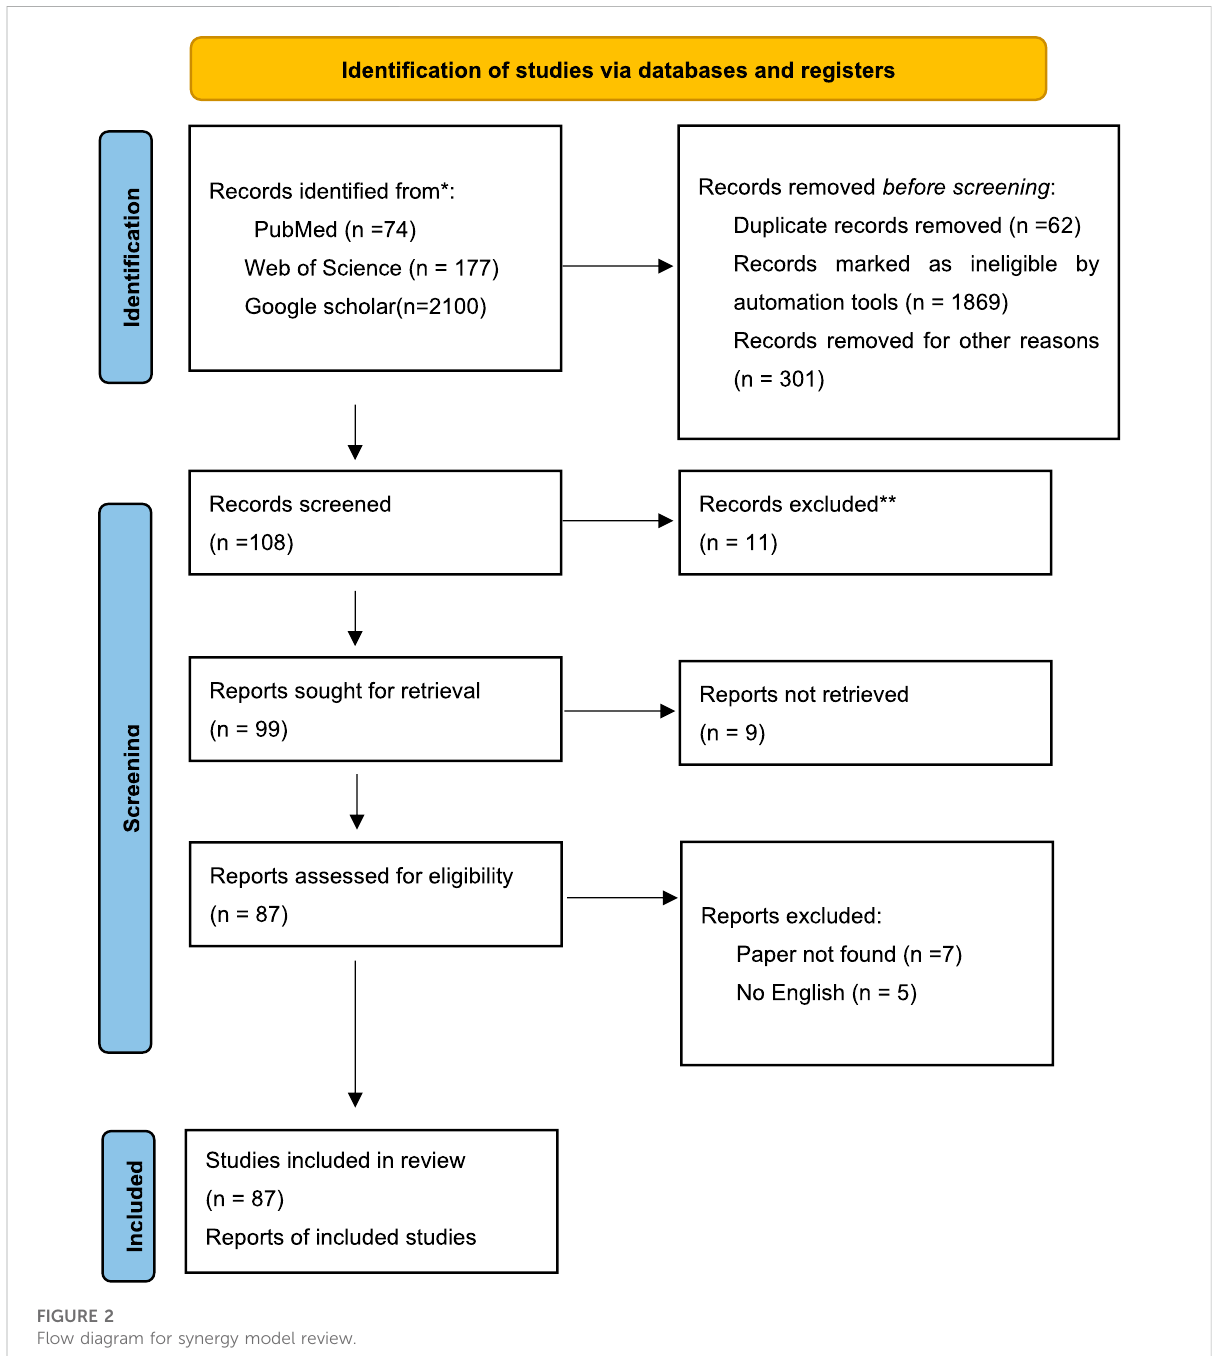
FIGURE 2 Flow diagram for synergy model